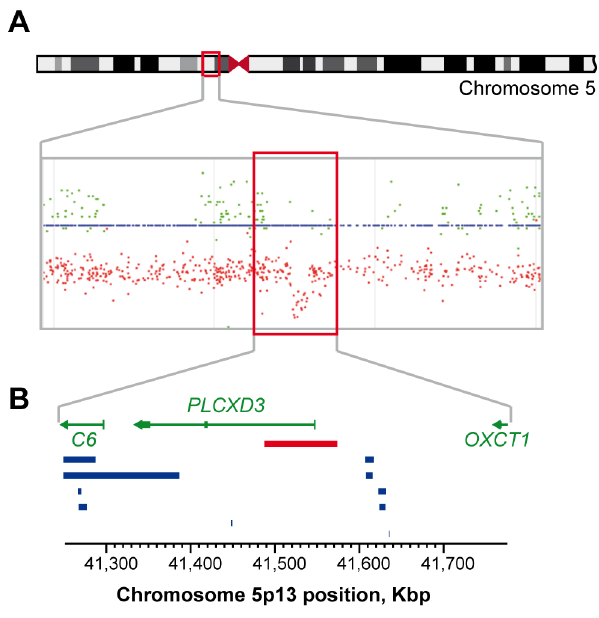
Figure 2. Copy number variation identified on chromosome 5p13. ( A ) Fluorescence level of SNPs of the region for the deleted patient visualized using SnipPeep. Red dots represent fluorescence level of SNPs and green dots correspond to the SNP heterozygocity. ( B ) Chromosomal position of the deletion. Gene position and annotation (http://genome.ucsc.edu/) are symbolised by green arrows. Deletions reported in the Database of Genomic Variants (http://projects.tcag.ca/ variation/) are represented with blue bars. No duplication has been reported in this region. A red bar represents the deletion identified in the patient with early-onset